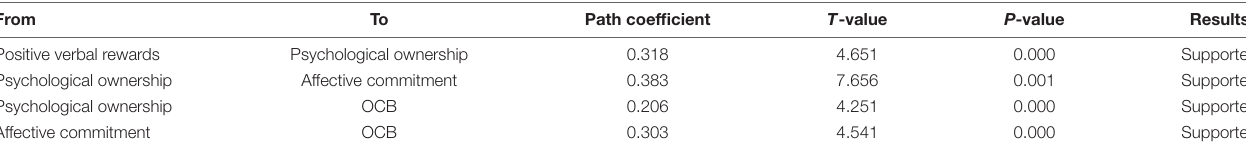
TABLE 5 | Results of measurement model. From